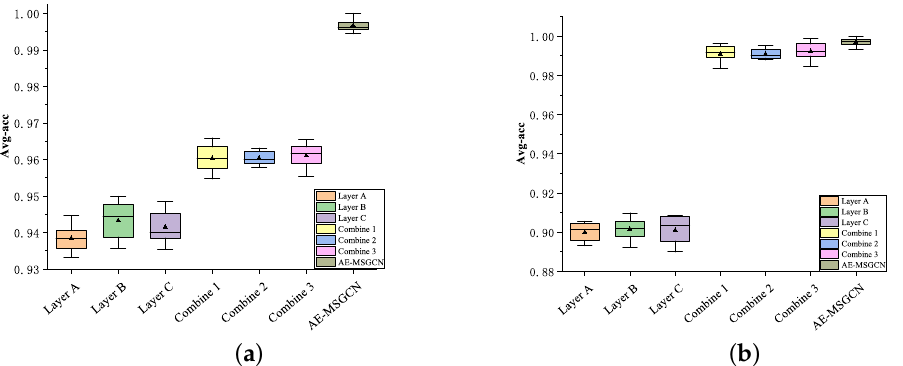
Figure 7. Average diagnosis accuracy of different methods (Combine 1 = Layer A + Layer B, Combine 2 = Layer A + Layer C, Combine 3 = Layer B + Layer C ): ( a ) SEU dataset, ( b ) CMO dataset.